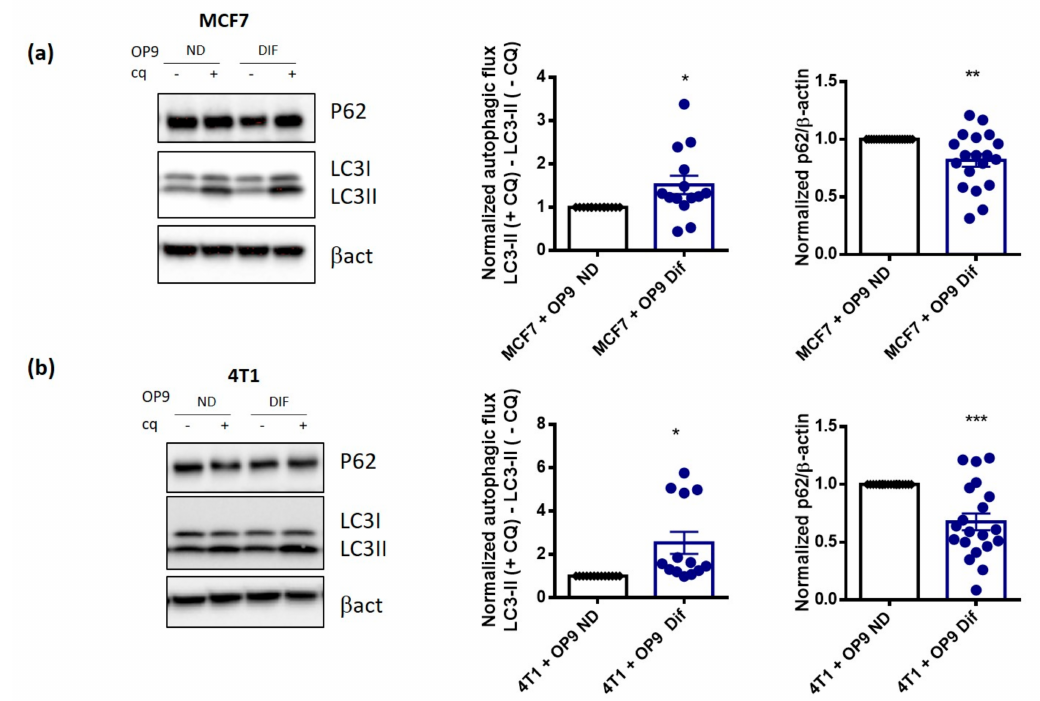
Figure 2. Co-culture with adipocytes activates autophagy in breast cancer cells. ( a , b ) Representative western blots and quantification of normalised autophagic flux and p62 protein expression in MCF7 ( a ) and 4T1 ( b ) cells in co-culture with OP9 ND and OP9 Dif for 48 h. To calculate the autophagic flux, 20 µ M chloroquine (CQ) was used for 18 h (Mean ± SEM, One sample t test, n = 13–14 for autophagic flux * p < 0.05; ** p < 0.01 and *** p < 0.001, n = 19–20 for